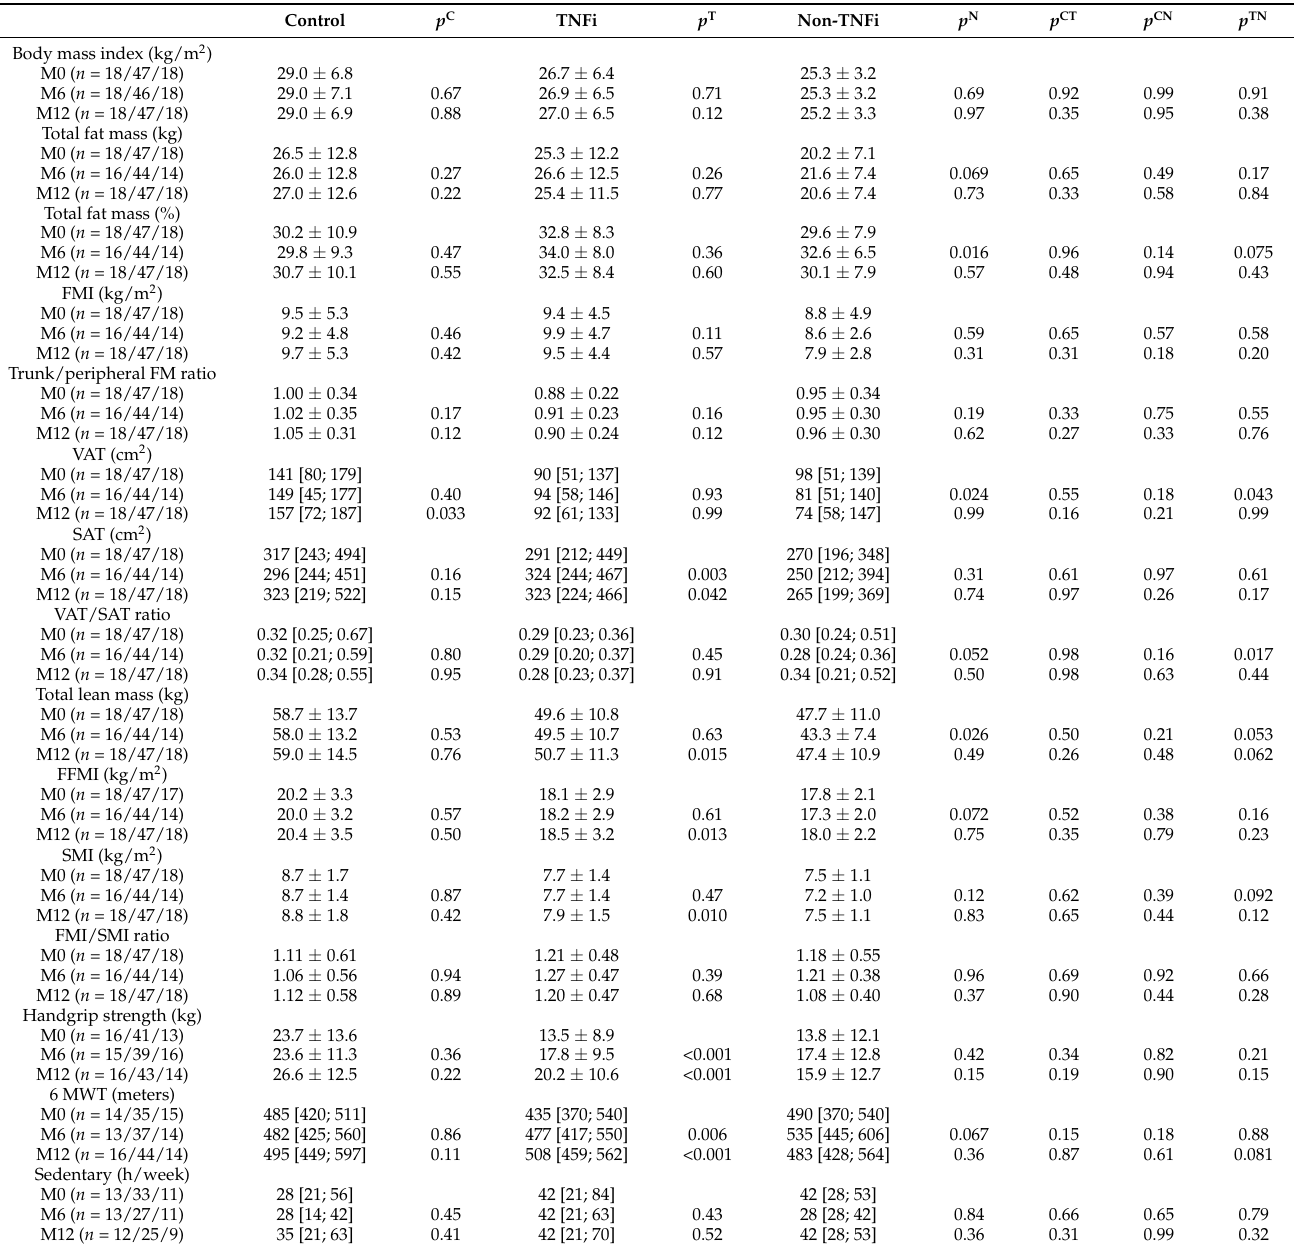
Table 3. Evolution of body composition and muscle function after 6 and 12 months of